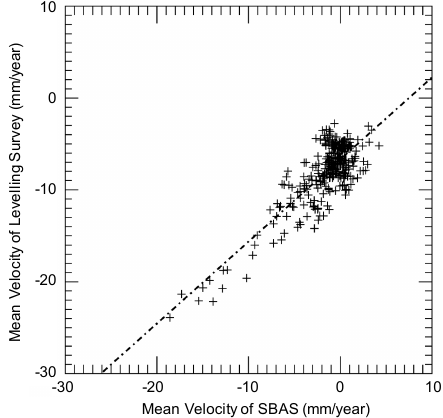
Figure 7. The reference mean velocities in the land observing satellite (LOS) direction calculated by the levelling data and GEONET data.